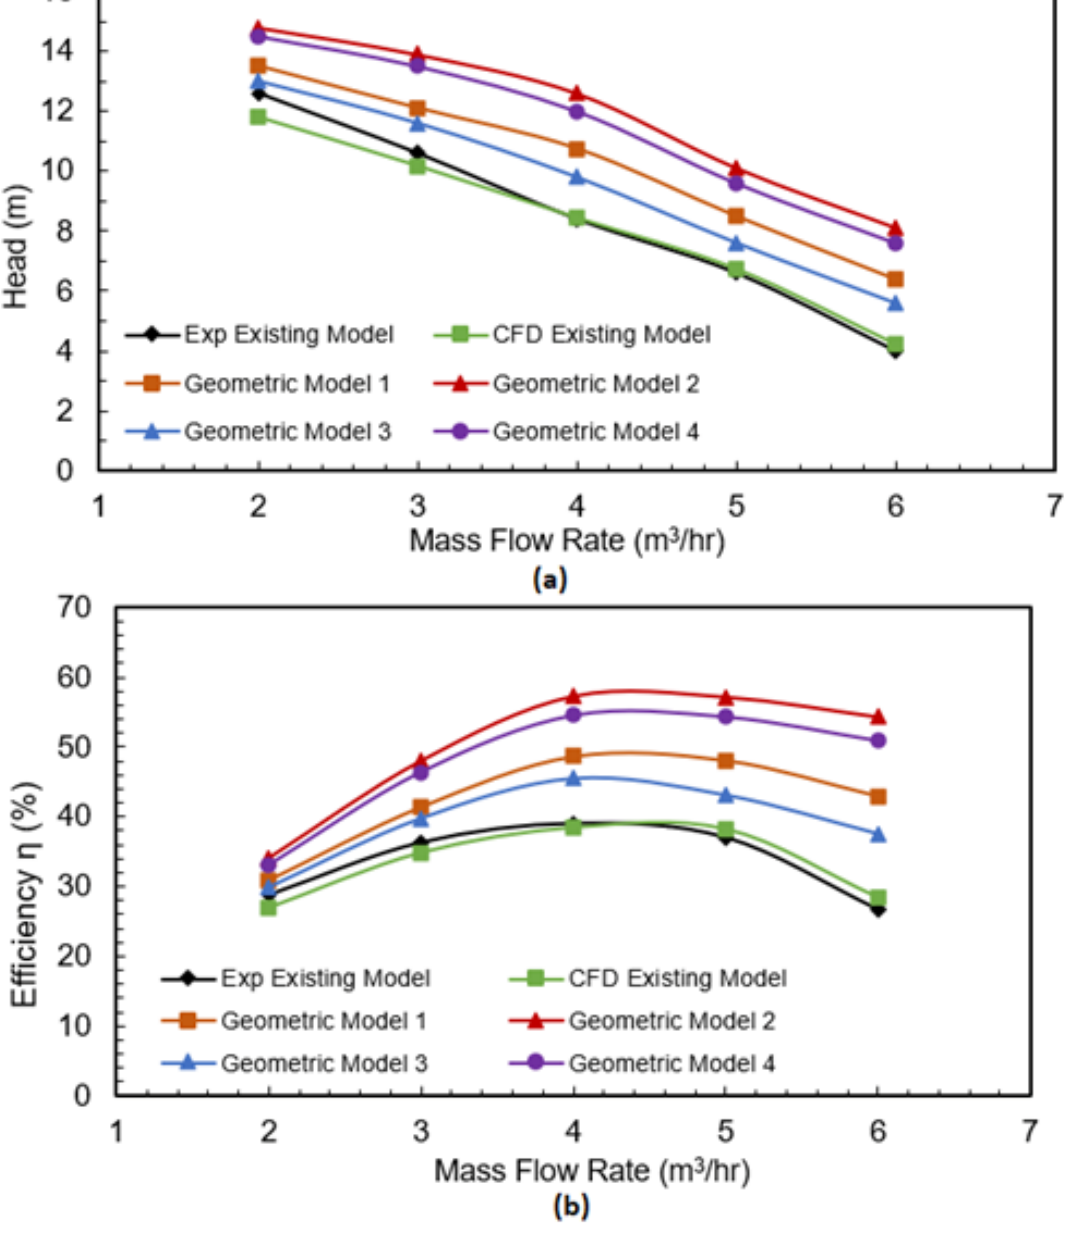
Figure 19. Hydraulic performances of the Liquivac pump with four different geometric models ( a ) Head-flow rate ( b ) Efficiency-flow rate.